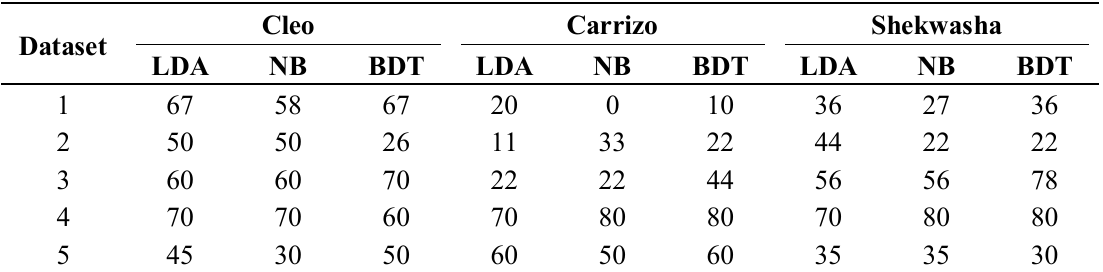
Table 1. Overall accuracy (%) of classification algorithms on data collected